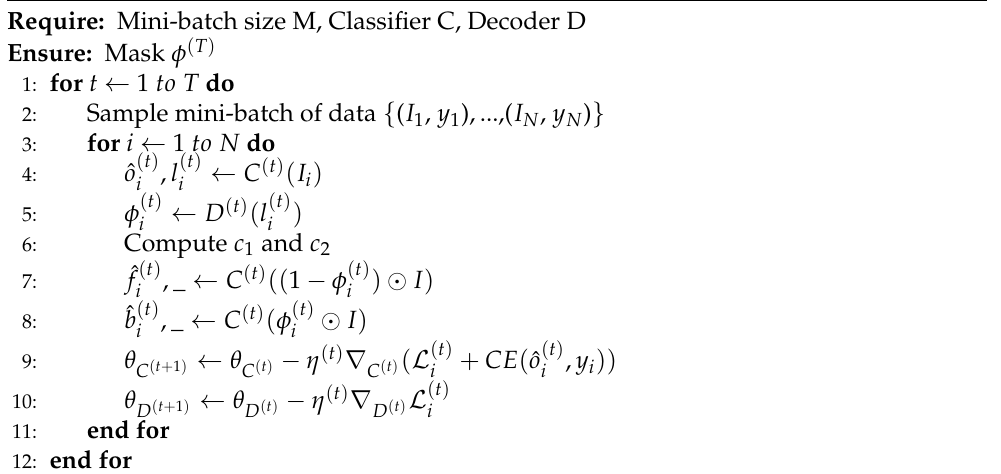
Algorithm 1 Chan–Vese Segmentation